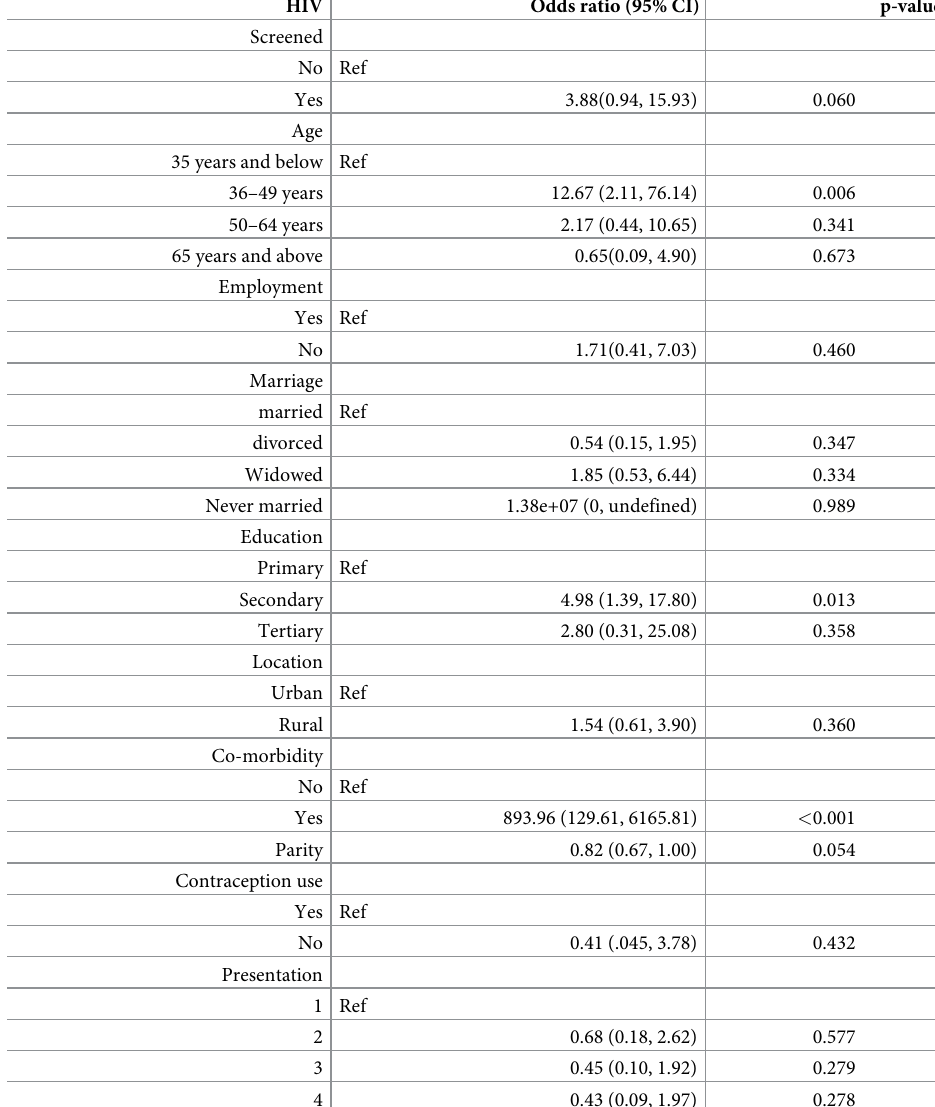
Table 5. Logistic regression: Factors related to HIV